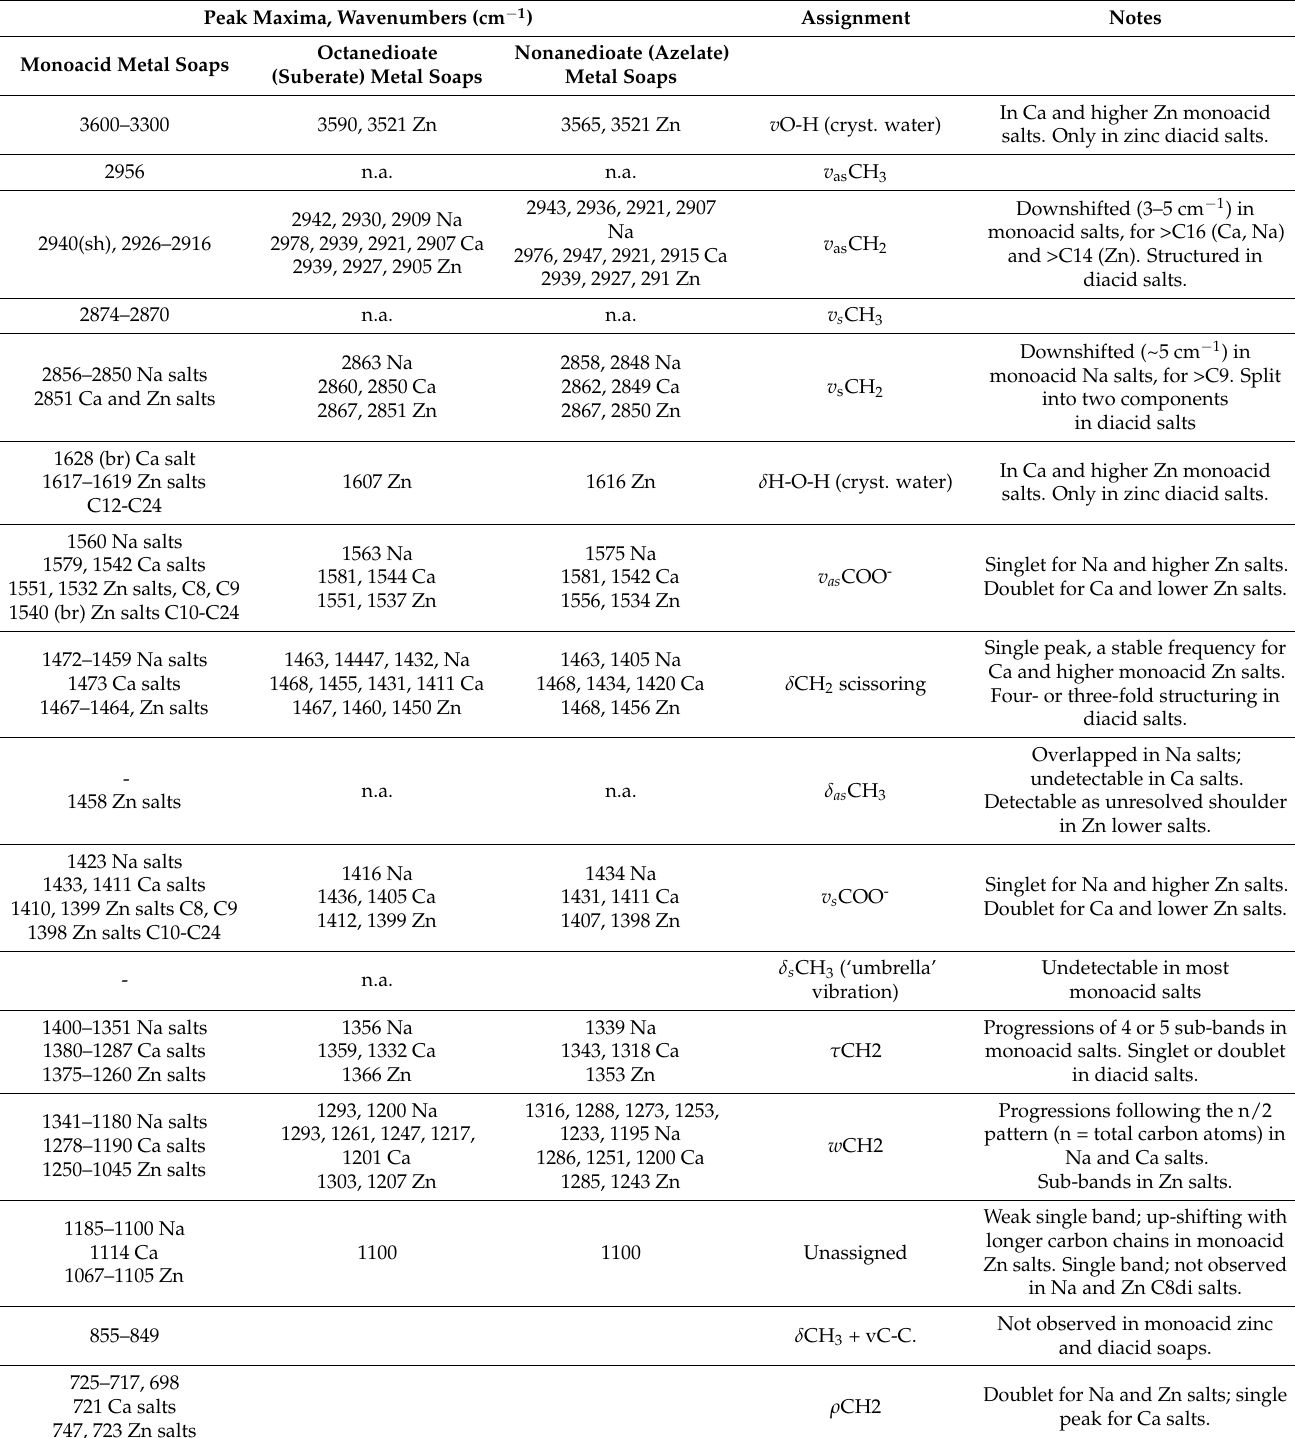
Table 2. Main infrared peaks and assignments of monoacid and diacid metal